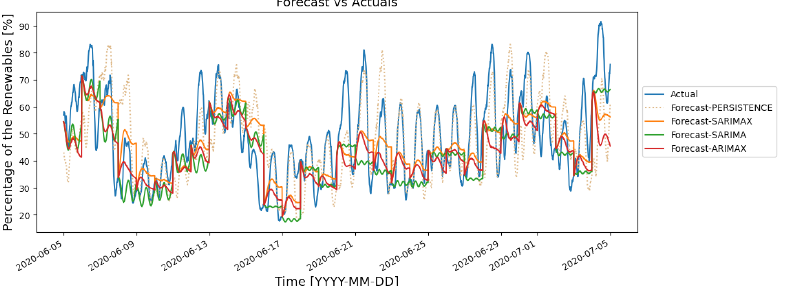
Figure 7. Forecasts for a one month period between late spring and early summer 2020.